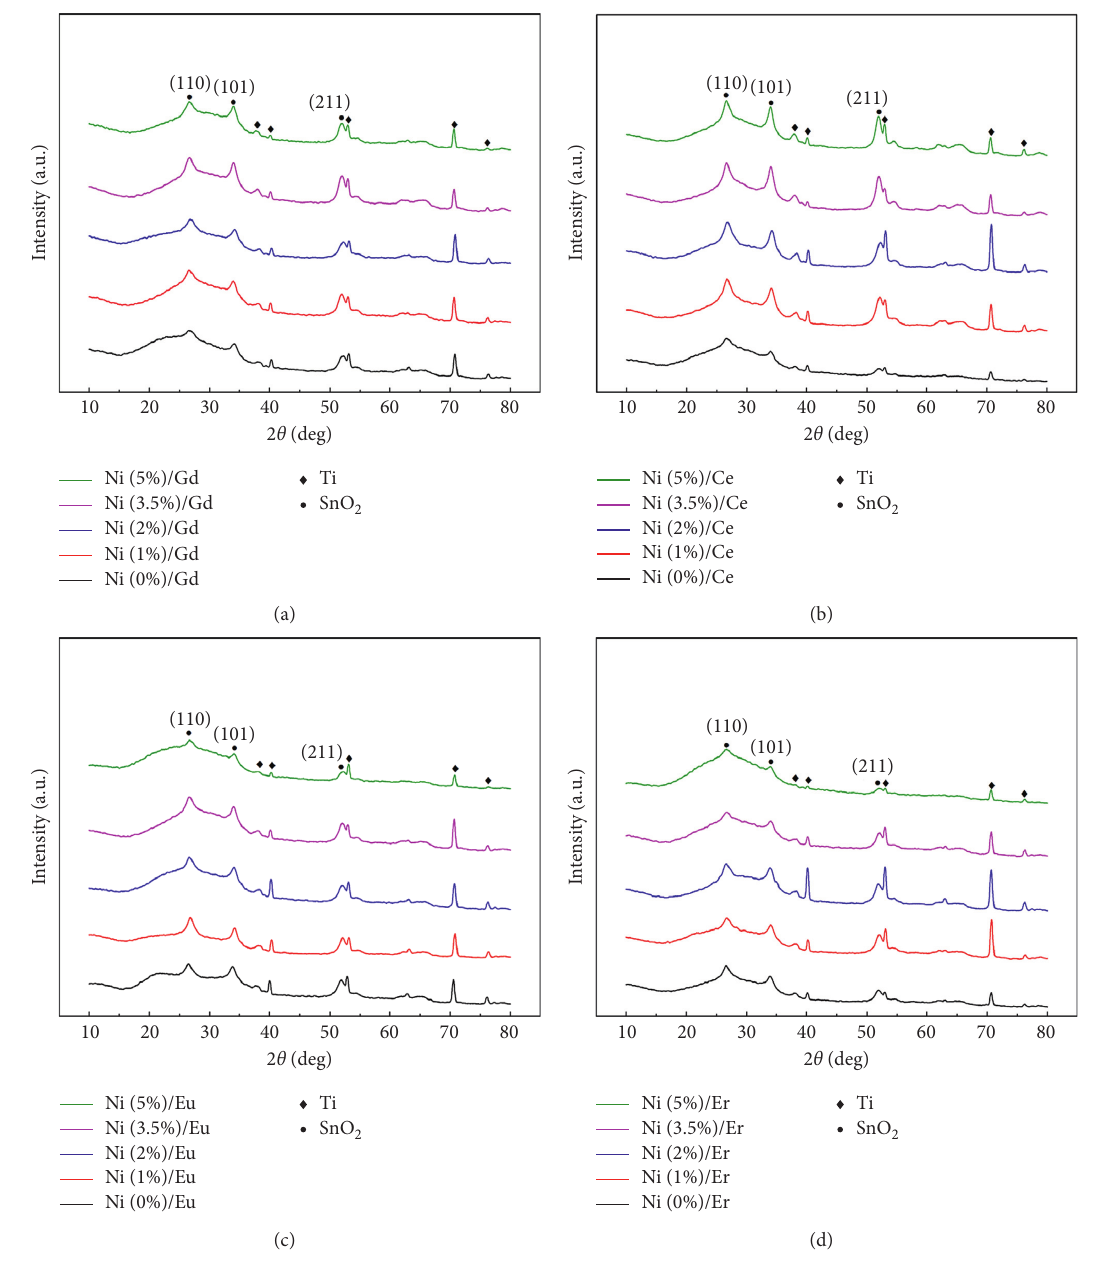
Figure 5: XRD patterns of Ti/SnO � (a) Gd, (b) Ce, (c) Eu, and (d) Er). 2 -Sb-Ni (0%, 1%, 2%, 3.5% and 5%)/Re electrodes. (Re Table 1: Coating composition of the electrodes (at. %). Percentage of Element